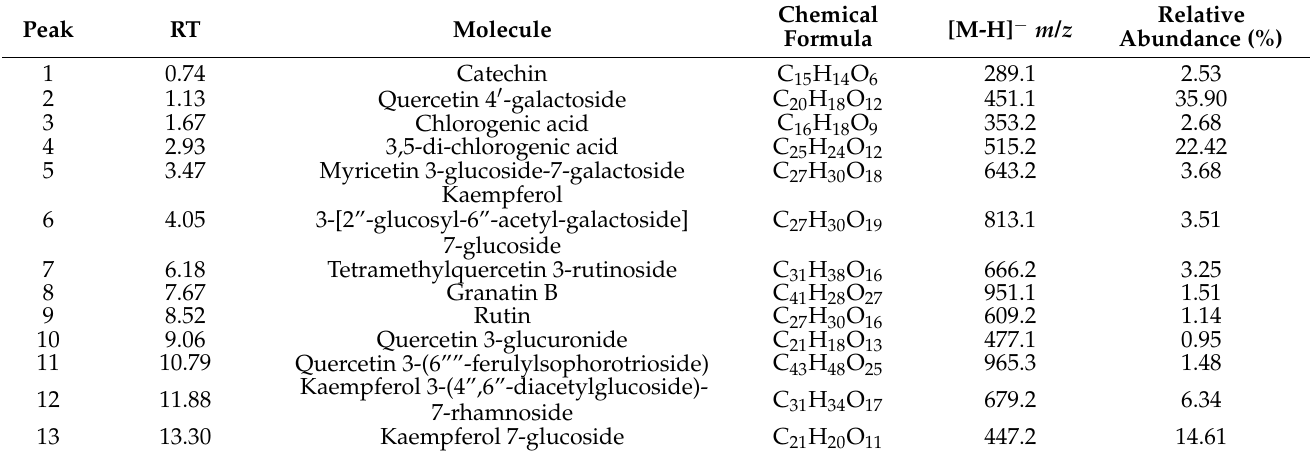
Table 4. Phenolic compounds identified by LC-MS/MS analysis of aqueous extracts of fruits of A. chilensis